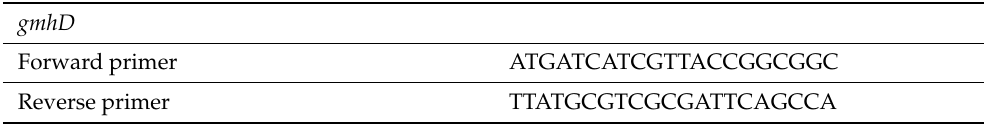
Table 2. Primer sequences used to amplify gmhD sequences for Sanger